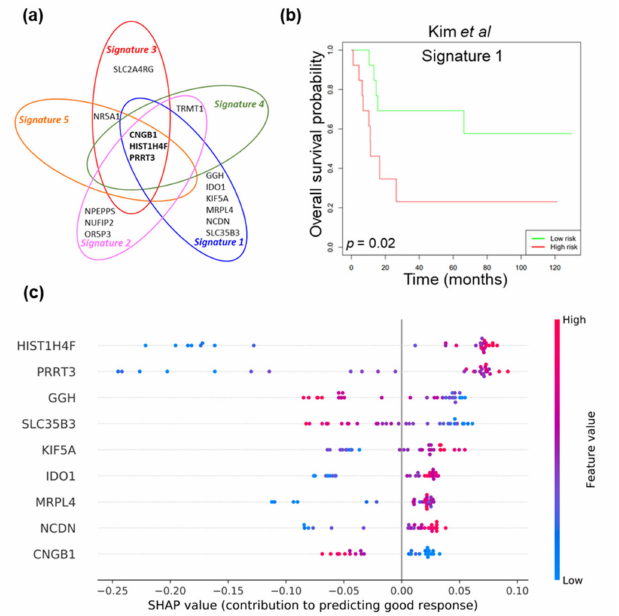
Figure 2. Machine learning approach to identify gene signatures predicting response to NAC. ( a ) Gene commonality of signatures identified by RGIFE machine learning algorithm, ( b ) A Cox proportional hazards regression analysis was performed to assess the relationship between expression of Signature 1 and overall survival in the Kim et al. dataset (Validation cohort 1) [30]. The model generated a survival risk estimate from the panel of markers comprising Signature 1 based on survival time and overall survival status. The model assigned a survival risk to each sample. The cohort was divided into two equally sized groups by the median risk (‘low risk’ and ‘high risk’). Kaplan-Meier plot shows Signature 1 significantly associated with overall survival in MIBC patients treated with NAC ( n = 26, Log rank test, p = 0.02) in Validation cohort 1, ( c ) SHAP summary plot showing the contribution that each gene of Signature 1 has in the prediction of good response for each patient sample in the Discovery cohort (SHAP value, the estimation of the contribution that each specific gene has in the prediction of good response for a given sample). A positive SHAP value indicates contribution to predicting good response to NAC. A negative SHAP value reflects a lack of support for predicting good response to NAC. i.e., contributes to predicting bad response. Blue and red points indicate low and high expressions of a gene,